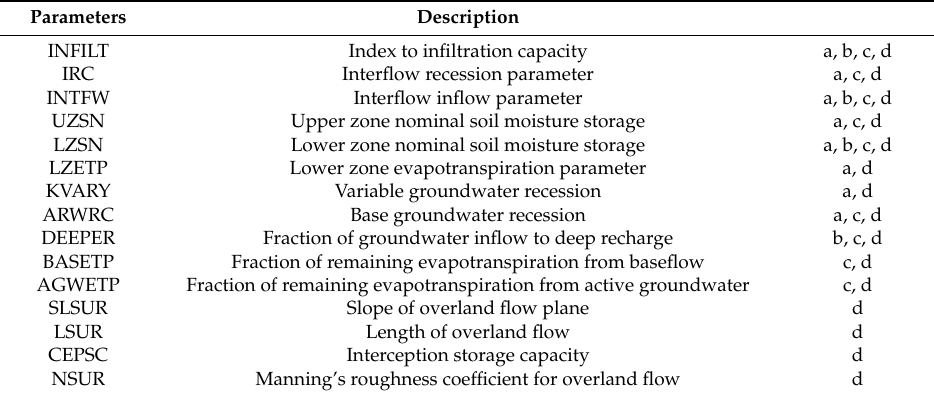
Table 2. Important parameters for the hydrologic components of the HSPF